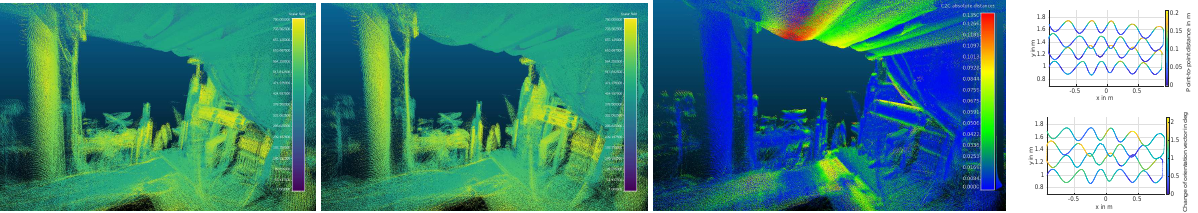
Figure 13. Sinusoid Distortion: Left: Input Point Cloud. Middle: Corrected point cloud. Right: Error between corrected and reference point cloud. Plots: Above: Point to point distance between the corrected and original trajectory. Below: Change of orientation vector between the corrected and original trajectory.